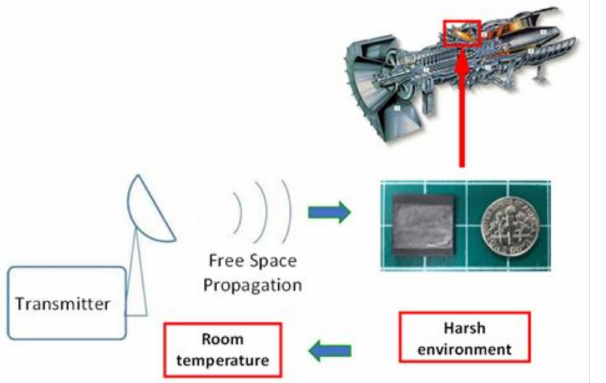
Figure 11. Wireless PDC temperature/pressure sensor that can be used to monitor the internal condition of a turbine engine.